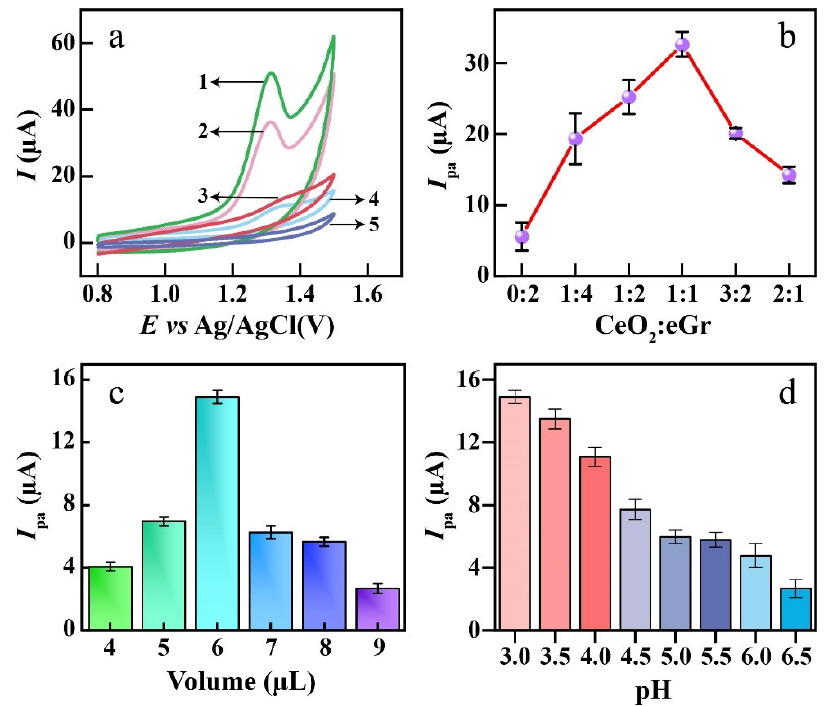
Figure 4. ( a ) CVs of CeO 2 /eGr/GCE (1), eGr/GCE (2), bare GCE (3) and CeO 2 /GCE (4) in 0.1 M PBS solution containing 50 μmol L −1 4-BPA at the scan rate of 100 mV s −1 , CeO 2 /eGr/GCE (5) in PBS solution without 4-BPA; ( b ) Influence of the ratio between CeO 2 and eGr on the response of 4-BPA based on LSVs. ( c ) the response of 10 μmol L −1 4-BPA to different volumes of composite nanomaterial in PBS solution (pH = 3). ( d ) Influence of pH on the peak current of 4-BPA in 0.1 M PBS solution.